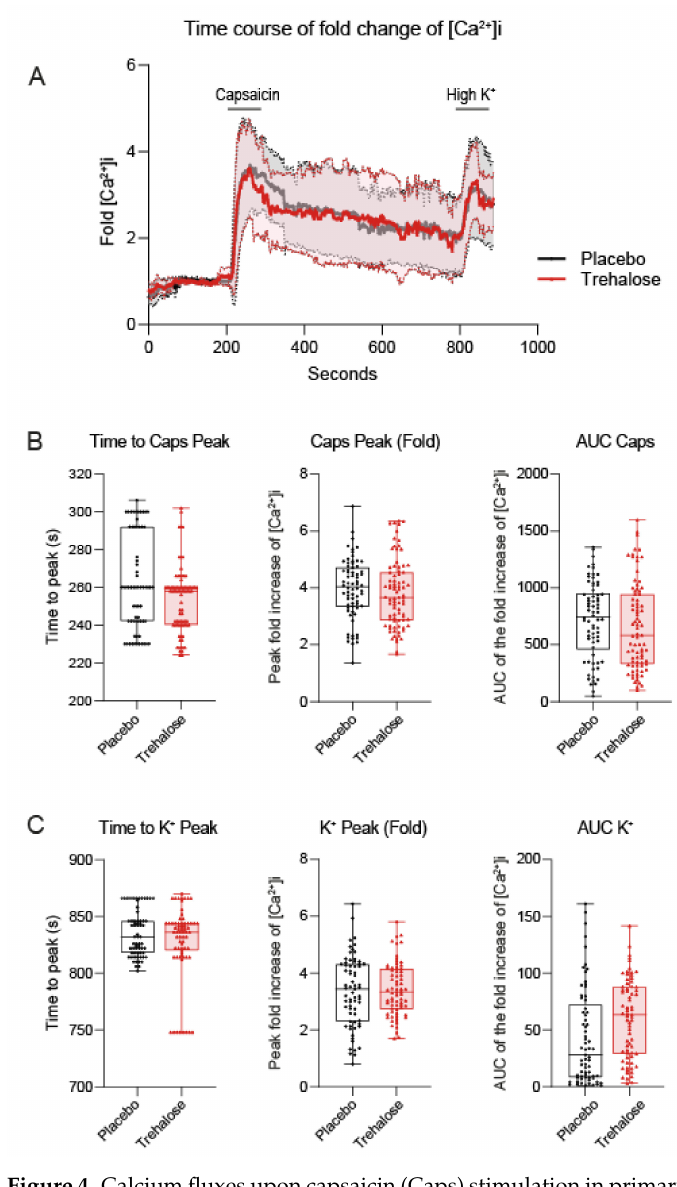
Figure 4. Calcium fluxes upon capsaicin (Caps) stimulation in primary neurons treated with trehalose or placebo. Neurons were prepared from the dorsal root ganglia (DRG) of naïve mice and were treated for 24 h with 10 mM trehalose or placebo before the analysis of calcium fluxes. ( A ): Time course of the fold change of intracellular calcium [Ca 2+ ]i, which shows the change of Fluo-4 absorbance versus baseline. Baseline was measured for 200 s, followed by 20 s capsaicin (Caps) to assess TRPV1- mediated calcium influx, and finally highly 50 mM potassium (K + ) for 20 s to assess depolarization- mediated calcium influx. The thick line is the mean, the filled areas show the SD. ( B , C ) Time to peak after capsaicin or highly concentrated K + , maximum change of [Ca 2+ ]i, and the area under the curve (AUC) of capsaicin or highly concentrated K + peaks. Data of n = 70 neurons per group were compared with unpaired, 2-tailed Student’s t -test. The box is the interquartile range, the line the median, the whiskers minimum to maximum, the scatters show individual